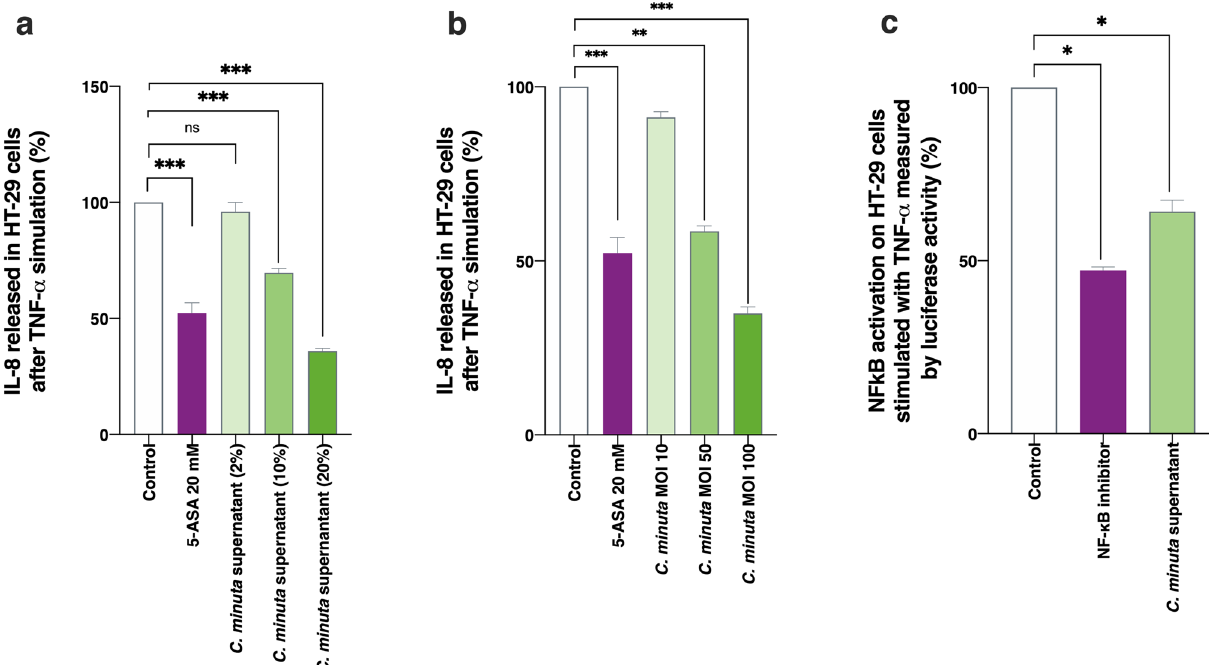
Figure 2. Anti-inflammatory properties of Christensenella minuta in vitro. IL-8 production by HT-29 cells exposed to TNF-α in presence of ( a ) C. minuta supernatant or ( b ) C. minuta bacteria. ( c ) Levels of NF-κB activation in HT-29 cells transfected with a reporter system and exposed to TNF-α. Results of Mann Whitney U tests comparing the control groups to the other groups: *p < 0.05, **p < 0.01, and ***p <